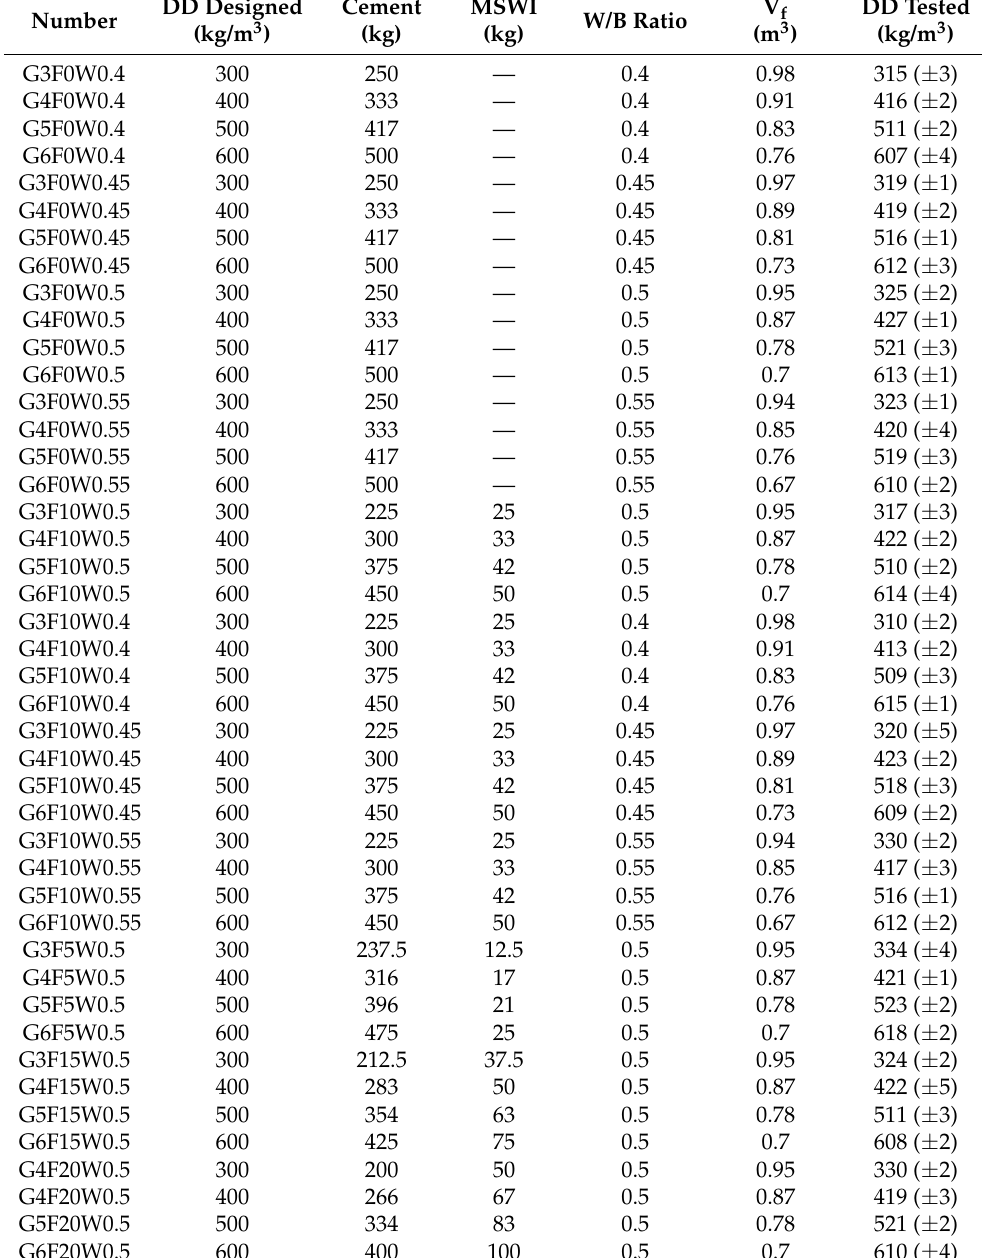
Table 2. Mixing proportions of the foamed concrete with MSWI